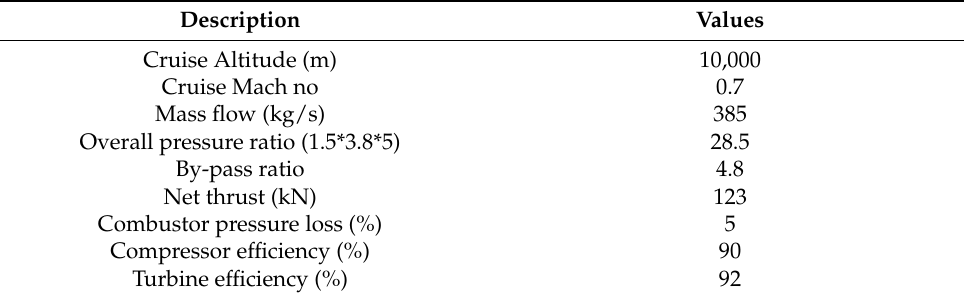
Table 1. Baseline take-off and cruise